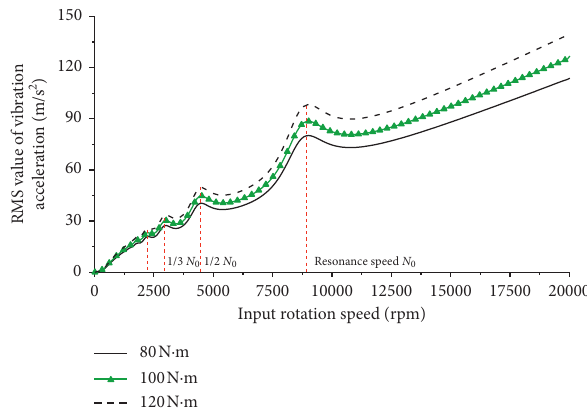
Figure 15: The vibration acceleration diagram under excitation of meshing impact of the single-stage gear system.